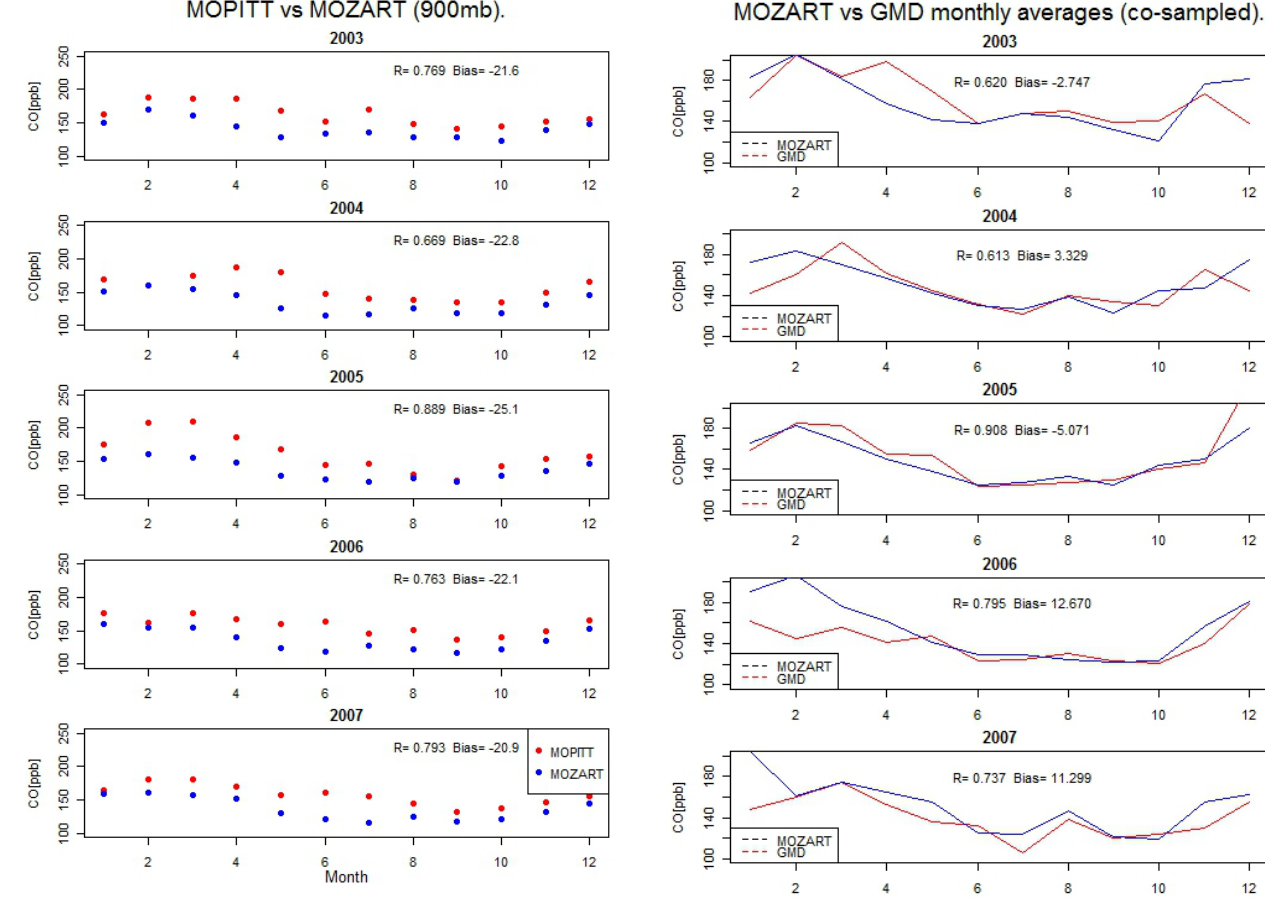
Fig. 8. Comparison of MOZART CO mixing ratio (at 964 hPa ) with co-sampled GMD flask measurements at Sde-Boker (31.13 ◦ N, 34.88 ◦ E, 400ma.s.l.) for the study period